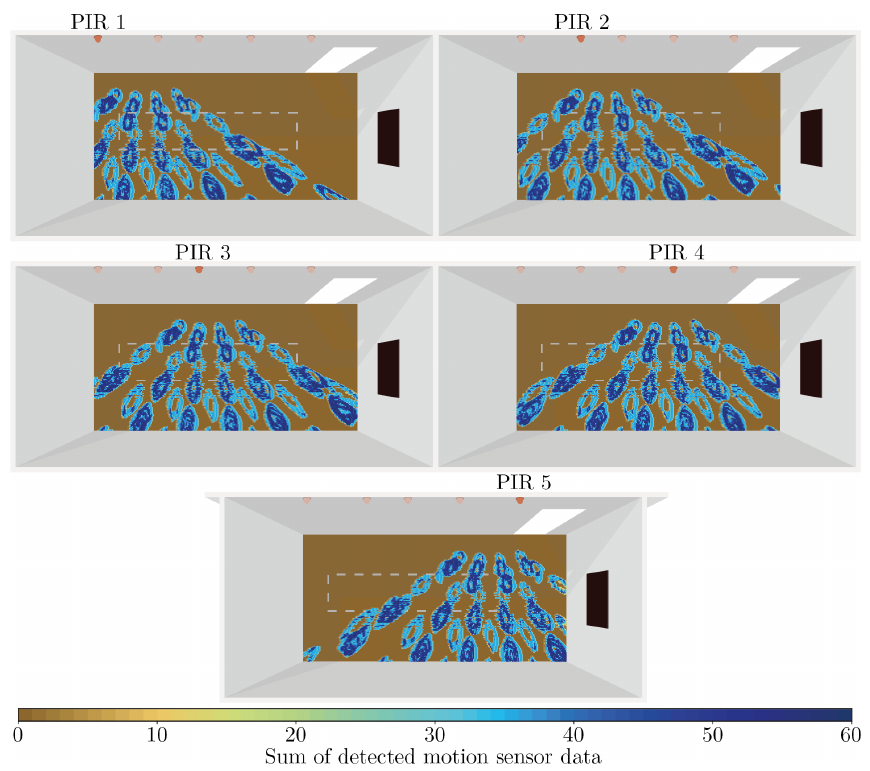
Figure 10. Heatmaps showing the sum of simulated motion sensor data caused by the spinning objects at various locations in the room. Each of the five subplots shows data registered by one of the five simulated PIR sensors. The white dashed rectangle indicates the position of the table in the room during Study